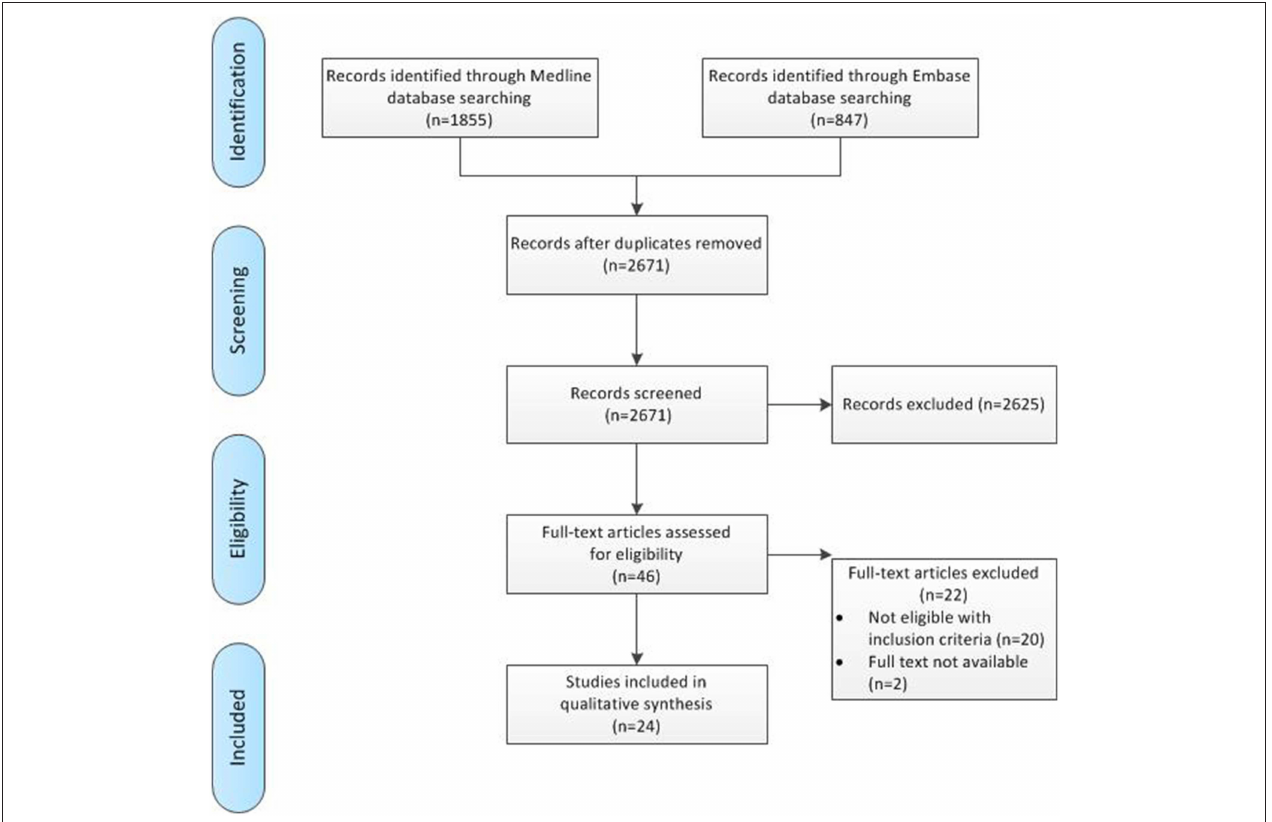
FIGURE 1 | Flowchart of pre-clinical search